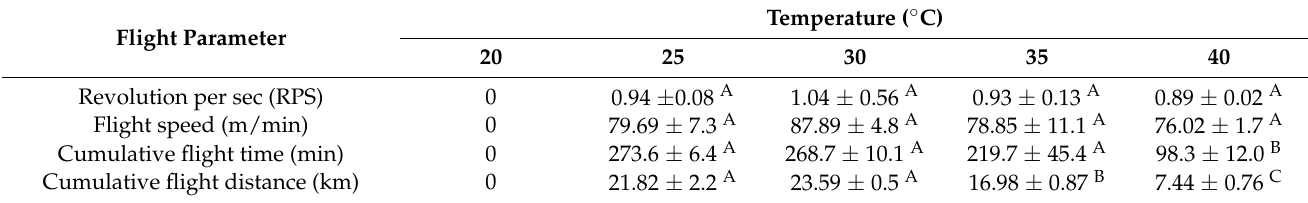
Table 2. Effect of temperature on flight parameter of RPW at RH of 35% using the computerized flight mill. Flight Parameter